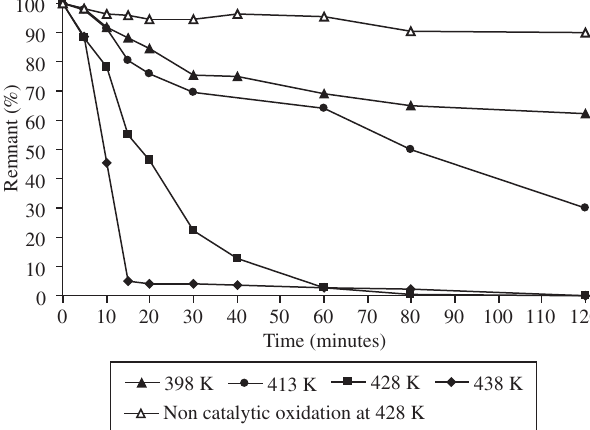
Figure 11. PVA reaction test response with apricot core activated